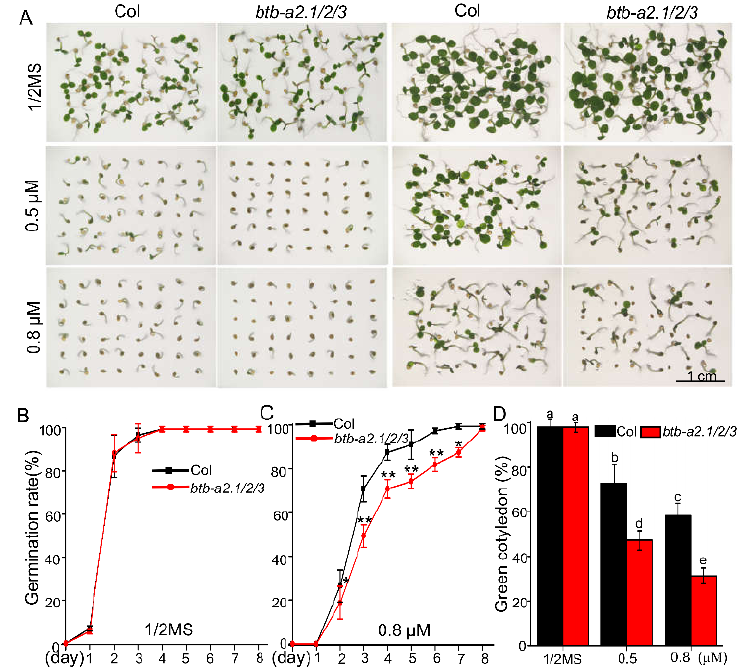
Figure 2. ABA responses of Arabidopsis btb-a2.1/2/3 during seed germination. ( A ) Germination of WT and Arabidopsis triple mutant btb-a2.1/2/3 in 1/2 MS medium without or with 0.5 μM, 0.8 μM ABA. The images were taken after three days (first two columns) and five days (last two columns) of stratification; ( B ) Germination rate statistics of WT and btb-a2.1 / 2 / 3 under normal conditions; ( C ) Germination rate